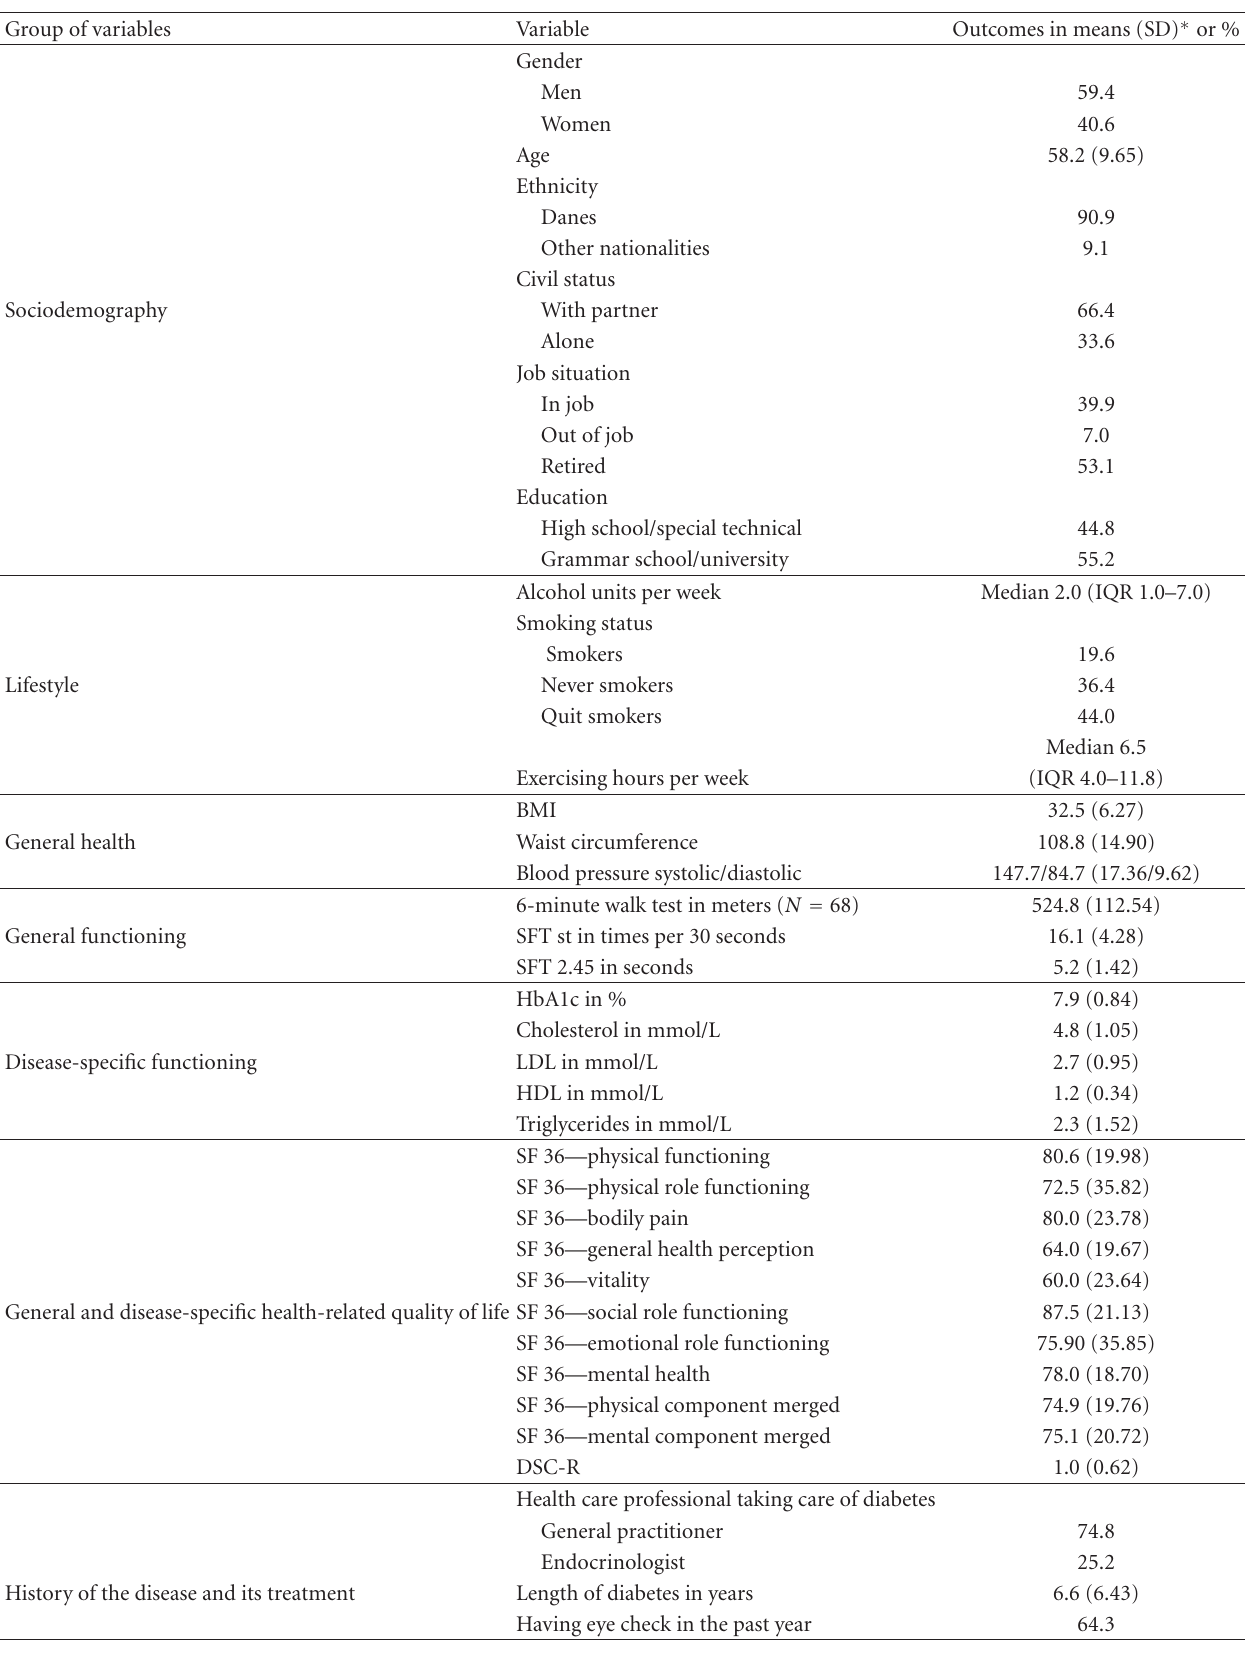
Table 2: Sample characteristics before intervention ( N =